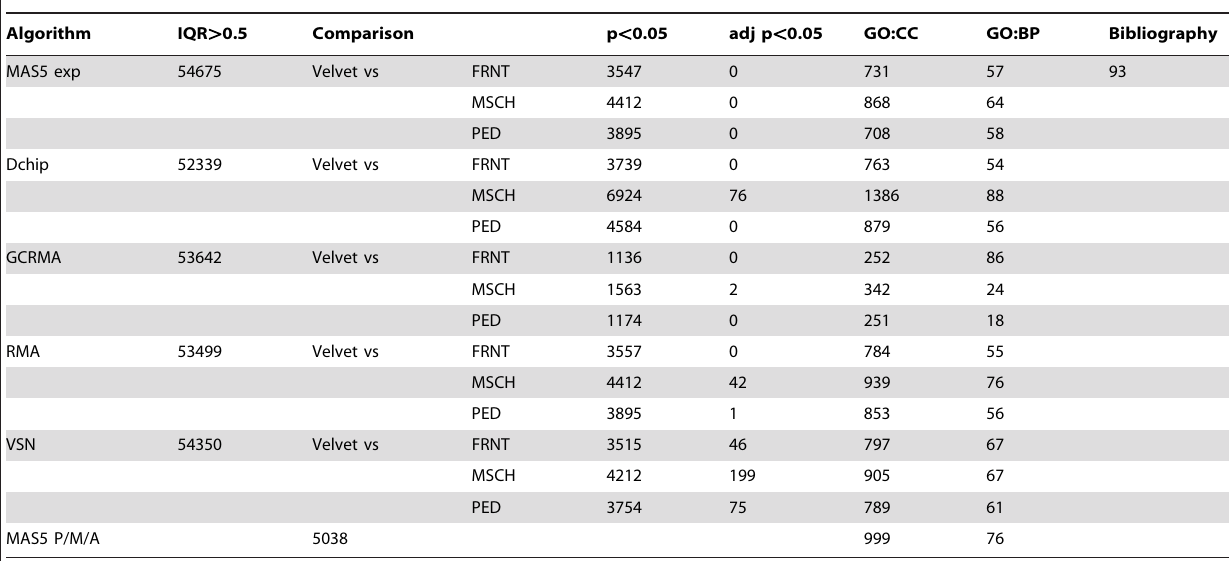
Table 1. Microarray data processing